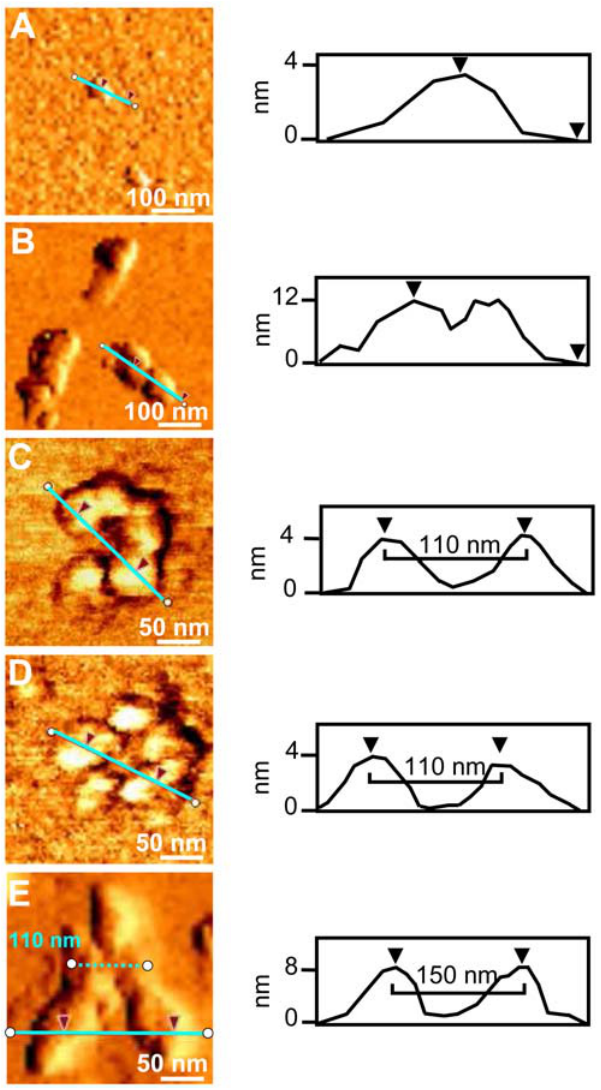
Figure 5. Cu II and TFE induced conformational change of Ub. A) Far-UV CD spectra of Ub incubated at 37 u C with 3 mol equiv of Cu II in 20% TFE for different time intervals: 1 h (blue line); 5 d (red); 1 mo (green); 2 mo (black); B) ATR-FTIR spectrum (absorbance at the top and second derivative at the bottom) in the amide I region of native Ub (blue line) and of Ub incubated with 3 mol equiv of Cu II in 20% TFE for 1 w (red) and 2 mo (black).